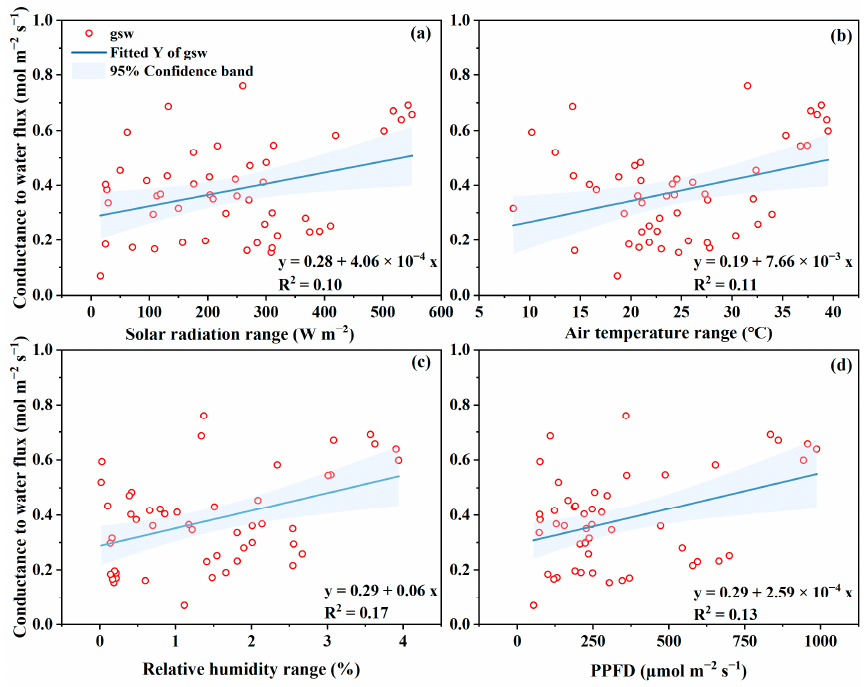
Figure 7. The relationships between stomatal conductance to leaf transpiration to solar radiation ( a ), air temperature ( b ), vapor pressure deficit ( c ) and the photosynthetic photon flux density (PPFD) reaching to leaf ( d ).